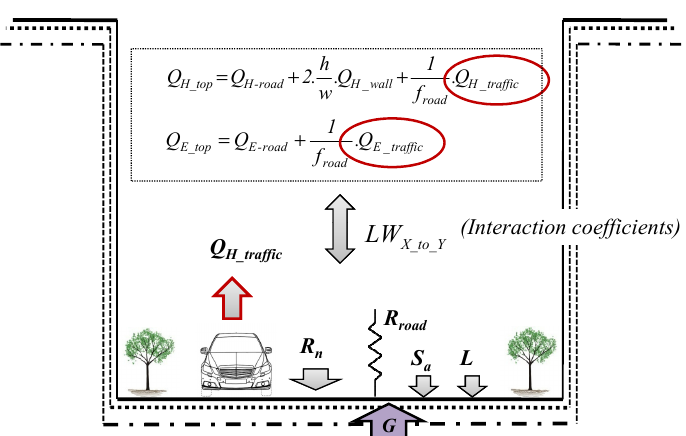
Figure 2. Different physical processes involved in the calculation of road surface energy balance in the initial TEB model